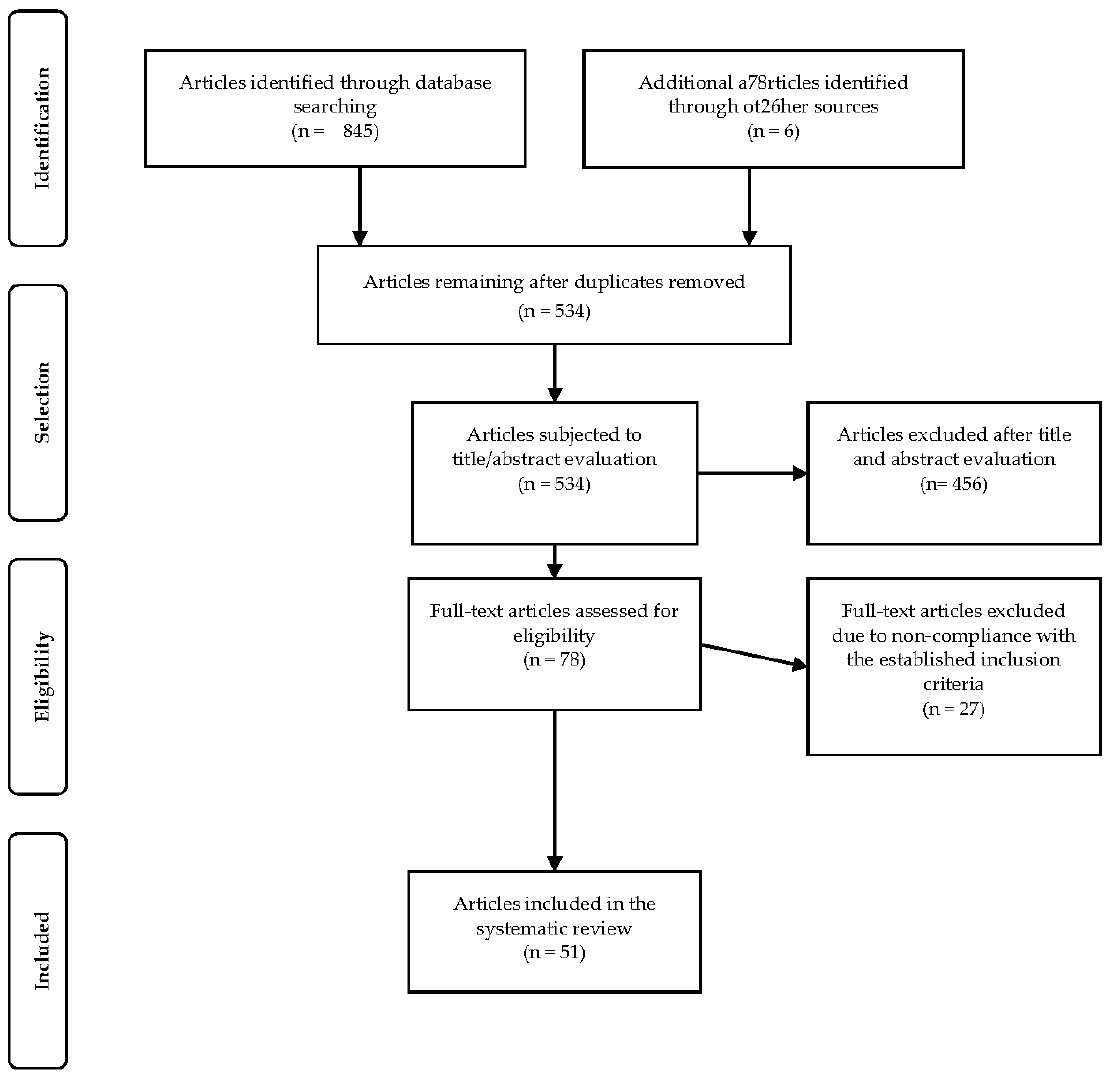
Figure 1. Preferred Reporting Items for Systematic Reviews and Meta-Analyses (PRISMA) flow diagram of the search and screening .